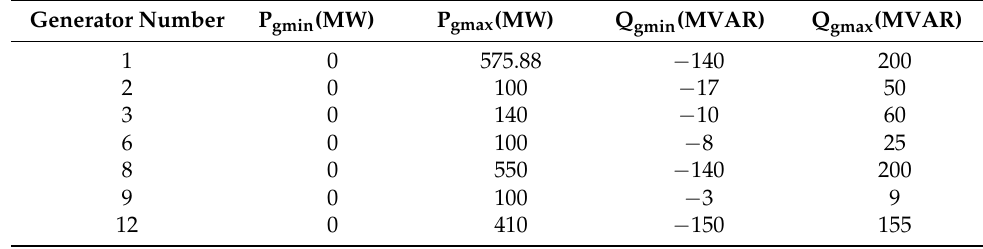
Figure 1. Single line diagram of IEEE 57 bus system two severe line outage contingencies. Table 1. Generation data of the IEEE 57 bus test